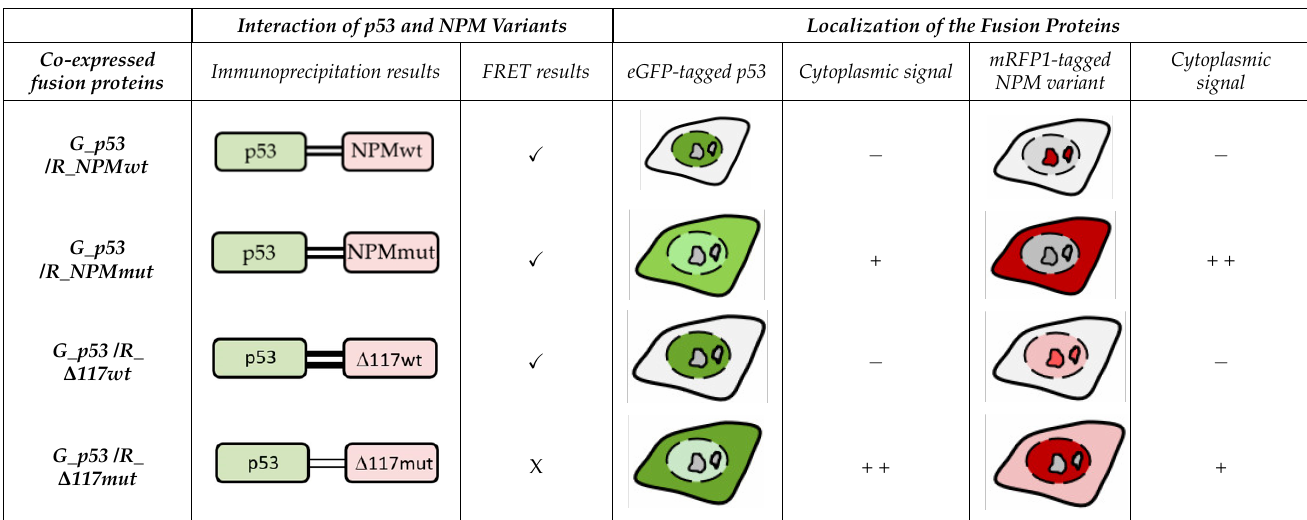
Table 2. Summary of interactions and localizations of p53 and the respective NPM variant specified in the first column. The left section outlines interactions of p53 with NPM variants and compares the immunoprecipitation and FLIM-FRET results. The right section schematically summarizes cellular localization of the respective fusion proteins. Abbreviations are defined in Table 1.